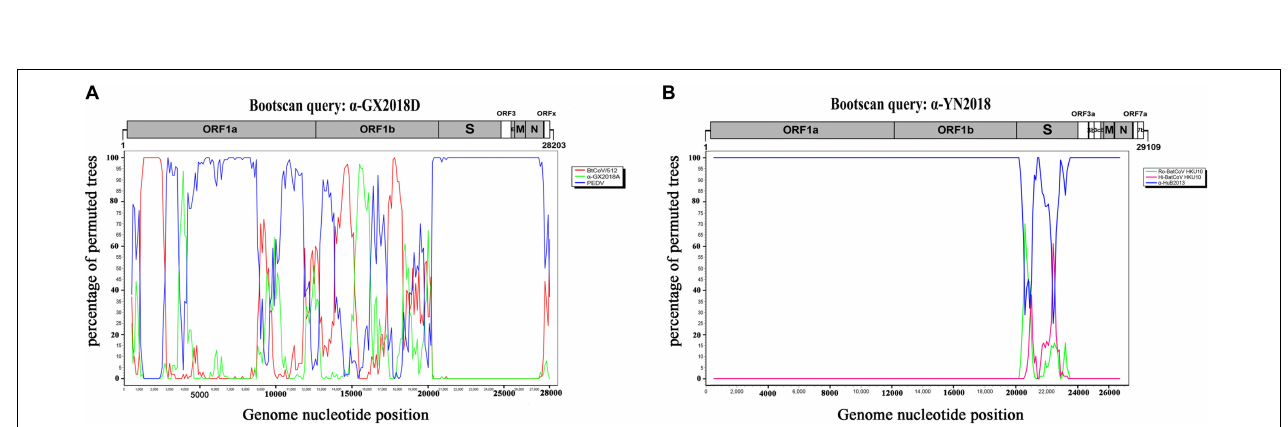
FIGURE 4 | Phylogenetic trees based on aa sequences of RdRp, S, S1, E, M, and N. The trees were constructed by the maximum likelihood method using appropriate models (WAG + G + I for RdRp and N; LG + G + I for S, S1, and E; rtREV + G for M) with bootstrap values determined by 1000 replicates. Only bootstraps > 40% are shown. The scale bars represent 0.05 (RdRp), 0.5 (S and S1), and 0.2 (E, M, and N), respectively.